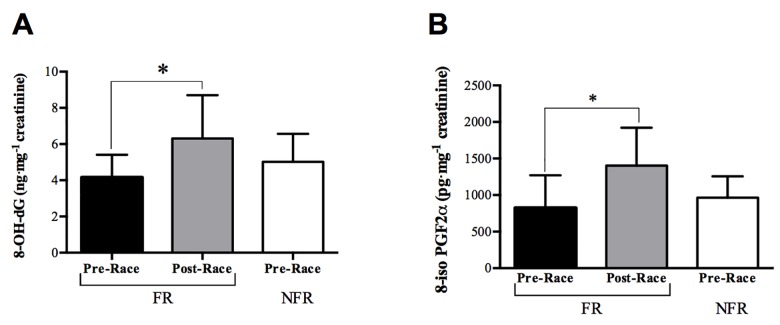
Effects of MUM on Oxidative damage biomarkers.Histograms of: A) 8-hydroxy-2-deoxy Guanosine (8-OH-dG, ng.mg-1 creatinine); B) 8-isoprostane (8-iso PGF2α, pg.mg-1 creatinine) concentrations in the FR and NFR groups at Pre and Post-Race. Results are expressed as mean ± SD;* significant differences (P<0.05) compared to Pre-Race.